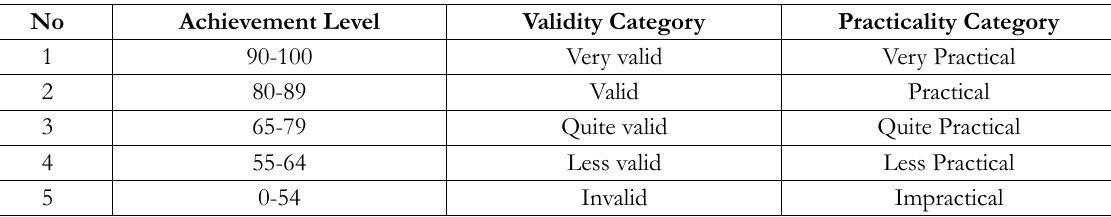
Table 2. Categories of validity, practicality and effectiveness